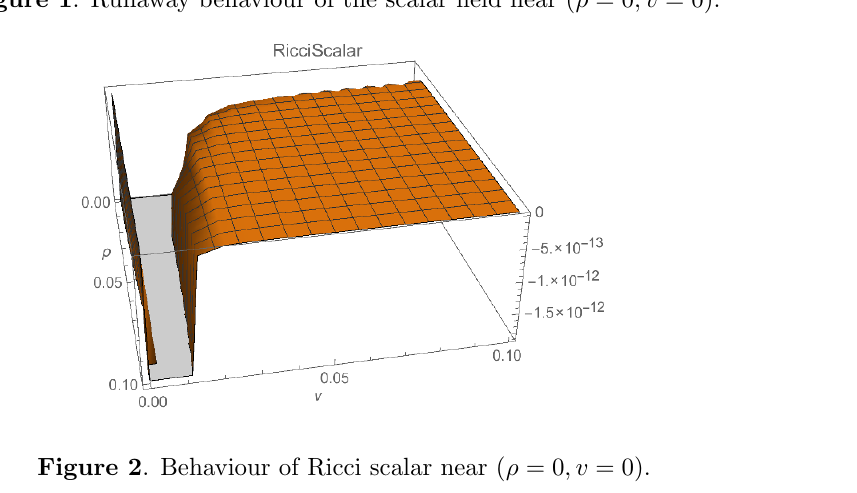
Figure 1 . Runaway behaviour of the scalar (cid:12)eld near ( (cid:26) = 0 ; v = 0).